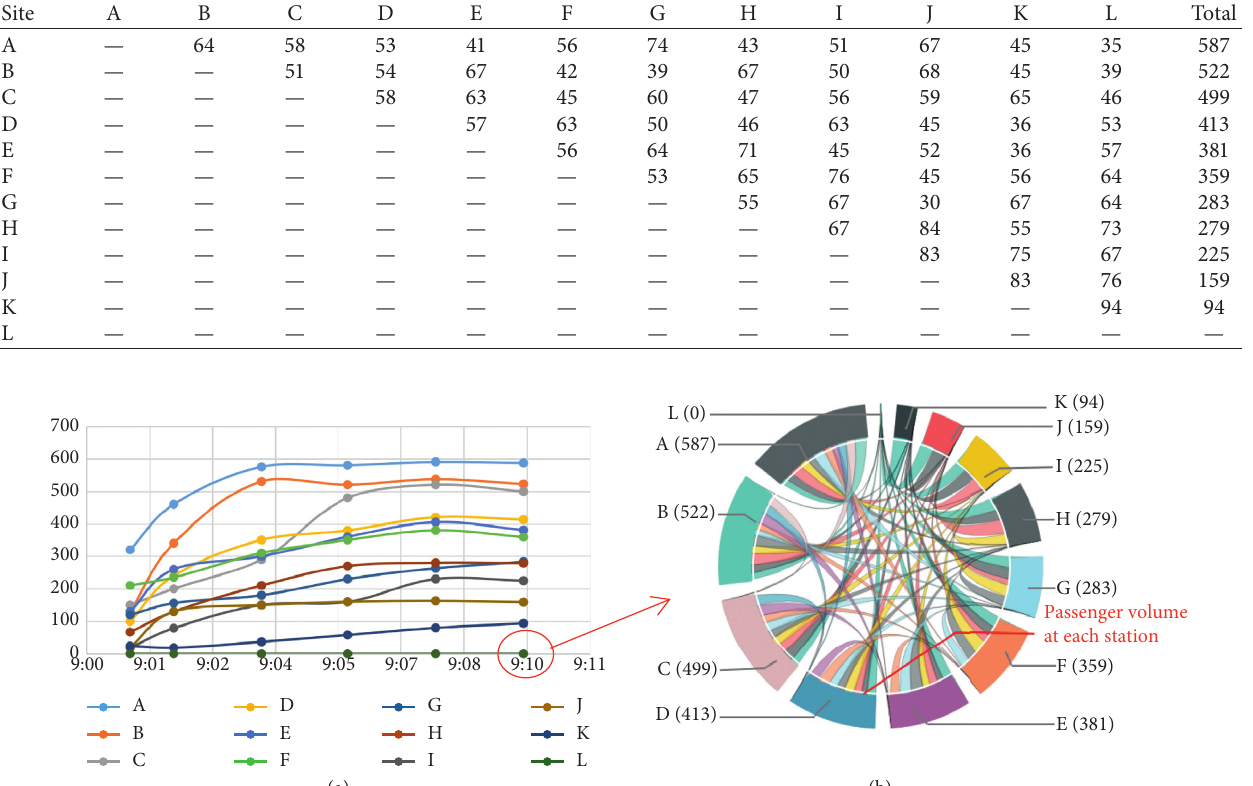
Figure 7: Passenger flow on/off at each station at the time of APP processing: (a) dynamic reservation number (9:01–9:10); (b) number of appointments by deadline